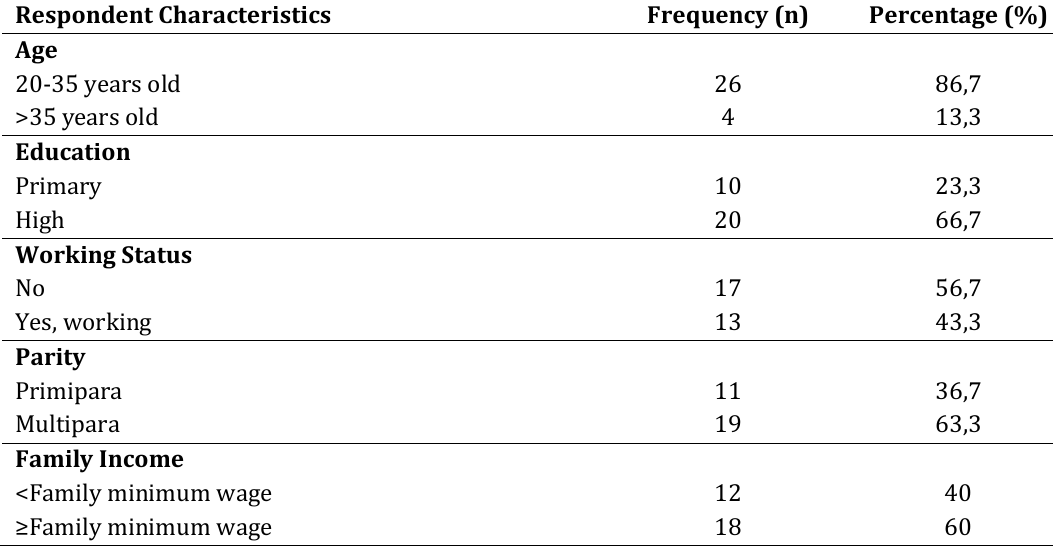
Frequency Distribution of Respondent